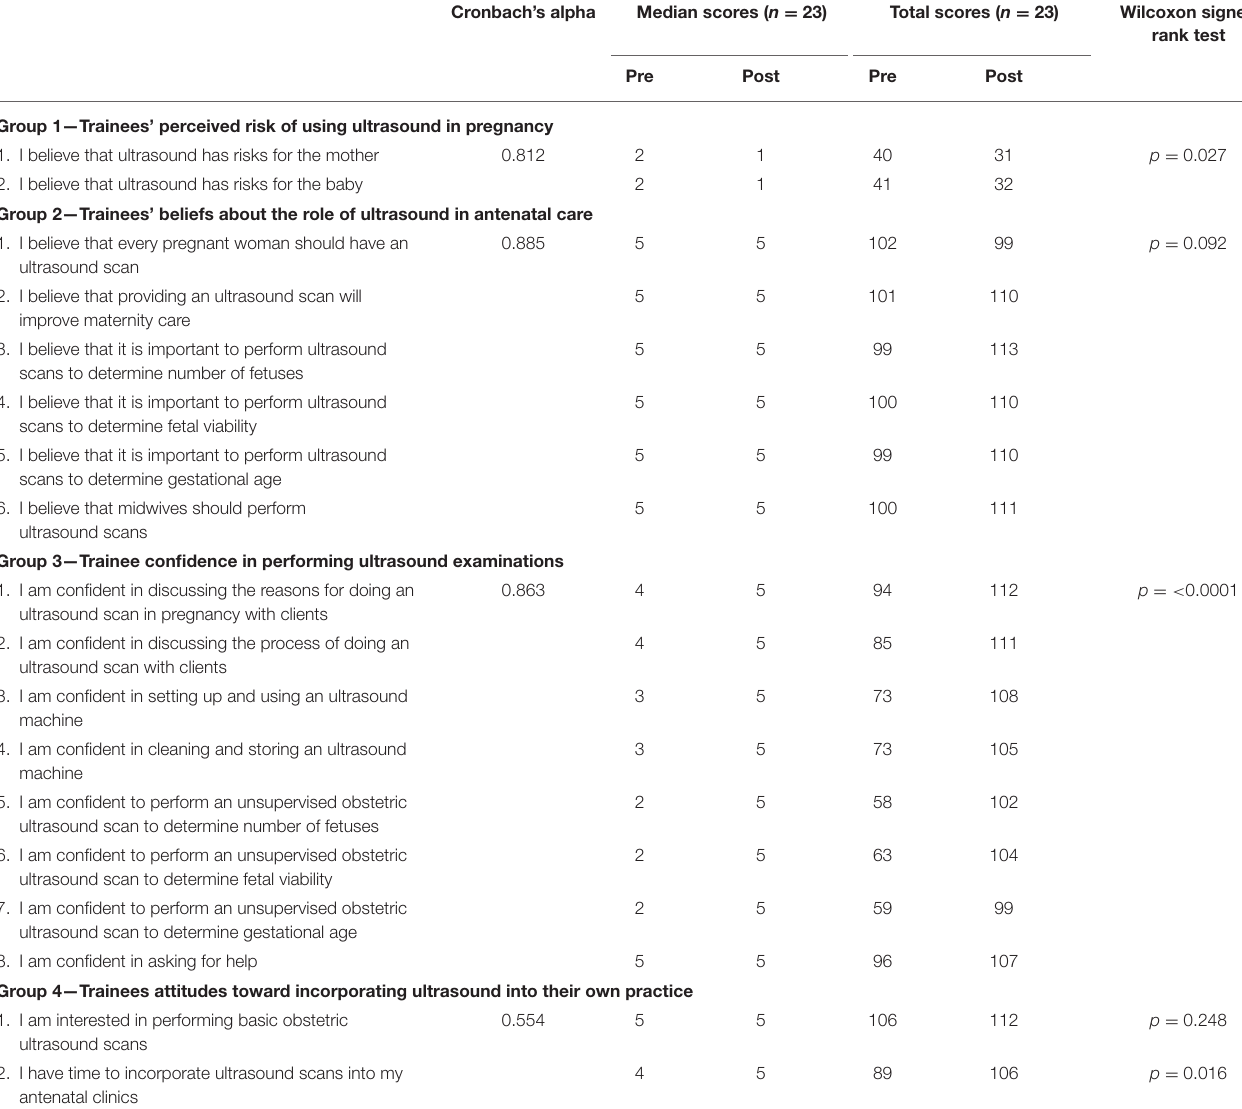
TABLE 3 | Pre and post course questionnaire groupings and